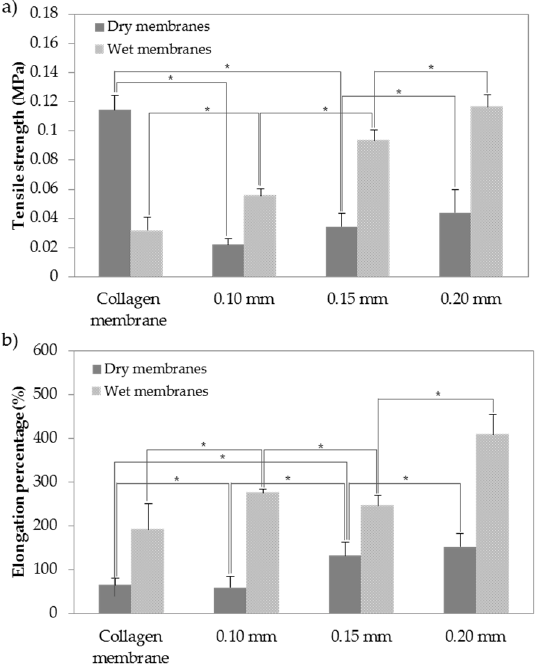
Figure 2. Mechanical properties of BC and Collagen membranes: ( a ) Tensile strength (MPa) of dry and wet membranes; ( b ) Elongation percentage (%) of dry and wet membranes. The “*” symbol indicates a significant difference ( p < 0.05).